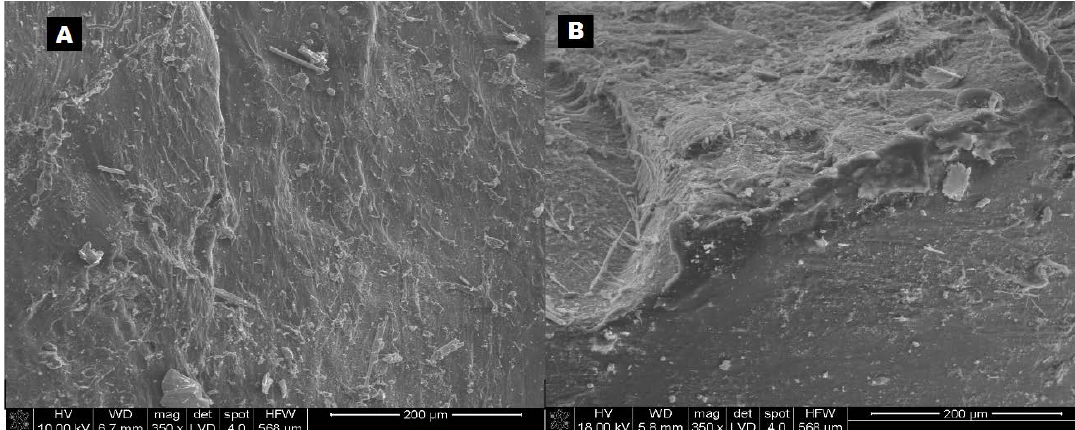
Figure 9. SEM investigations of ( A ) the 15L and ( B ) the 15LMMT samples with the magnification of